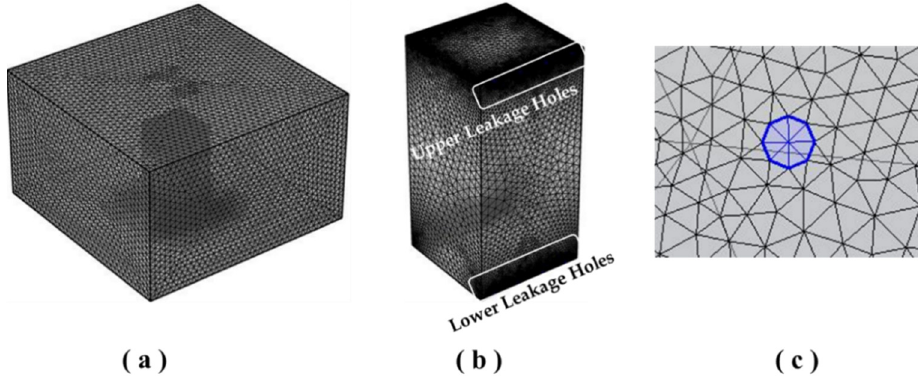
Figure 6. Overview of the geometry and mesh used in numerical analysis: ( a ) Overview of the total domain; ( b ) overview of the enclosure; ( c ) overview of the leakage hole. Table 3. List of mesh sizes and elements for modeling.